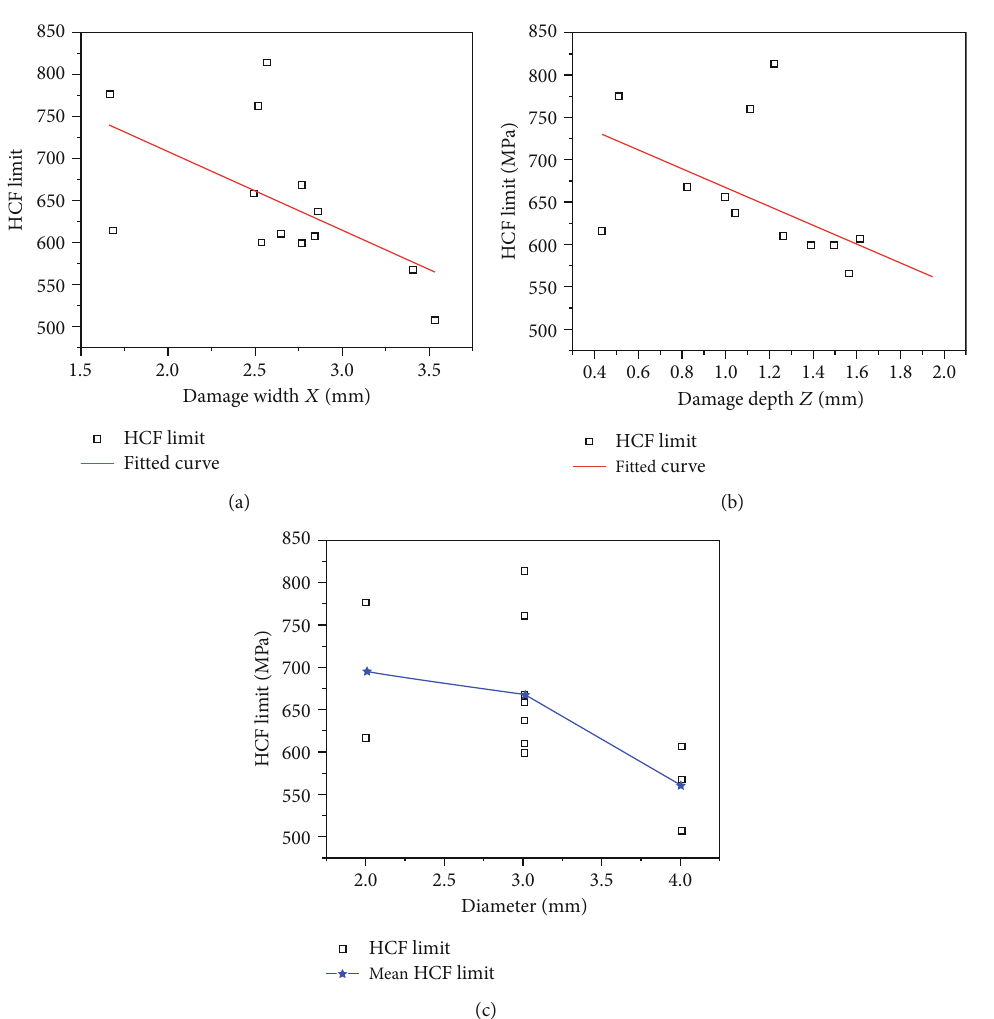
Figure 11: The relationship between HCF limit and FOD parameters: (a) HCF limit with damage width X ; (b) HCF limit with damage depth Z ; (c) HCF limit with steel ball